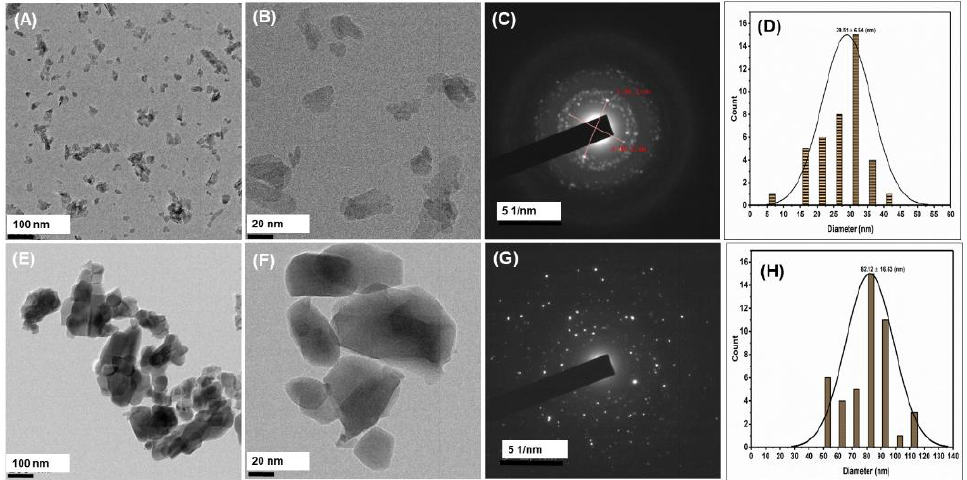
Figure 6. HR-TEM images ( A and B ) for alkali-treated nano HA, respectively, and images ( E and F ) for thermally calcined nano HA, respectively, and images ( C and G ) SAED pattern of alkali-treated and thermally calcined nano HA, respectively, and images ( D and H ) are histogram ob- tained from the particle size distribution of the alkali-treated nano HA and thermally calcined nano HA, respectively.